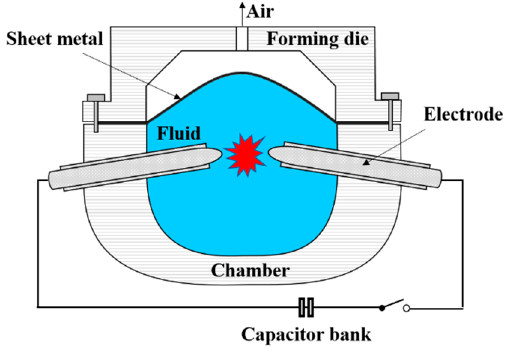
Figure 1. Conceptual diagram for electrohydraulic forming.